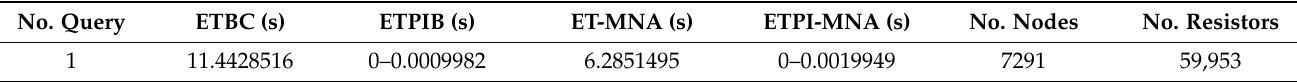
Figure 11. A 3 DOF manipulator collision-free path of query 1 (sequence of configurations): ( A ) = ( 60 ◦ ,10 ◦ , − 80 ◦ ) ; ( B ) = ( − 60 ◦ , − 35 ◦ , − 30 ◦ ) . Table 3. Execution time of case study 1 (3 DOF manipulator). ETBC: execution time of bitmap creation, ETPIB: execution time per iteration in the bitmap creation process, ET-MNA: execution time of MNA creation, ETPI-MNA: execution time per iteration in the MNA creation